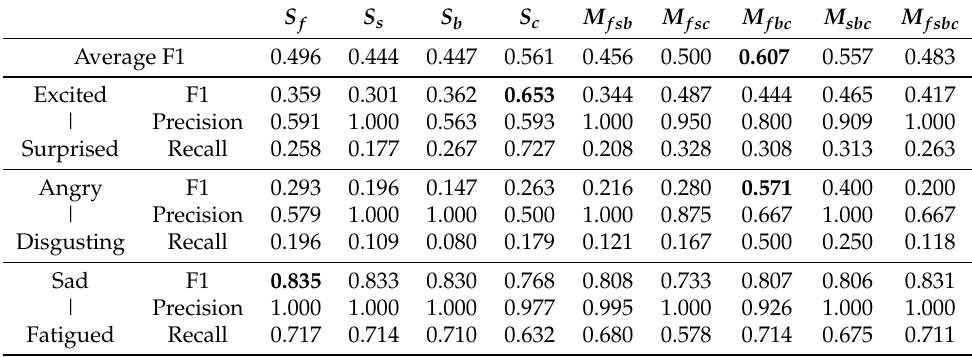
Table 8. Performance of driver emotion recognition among inducible emotions of Driver